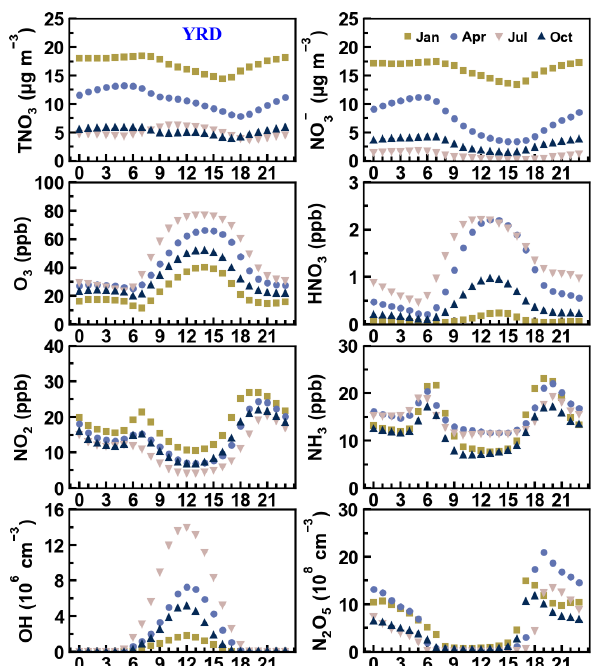
Figure 4. Monthly diurnal variations of three nitrate phases (NO 3 − , HNO 3 , and TNO 3 ), the major nitrate precursors (NO 2 , NH 3 , and N 2 O 5 ), and atmospheric oxidants (O 3 and OH) for the entire YRD region under the base scenario. The x axis marks each hour of the day (local time in